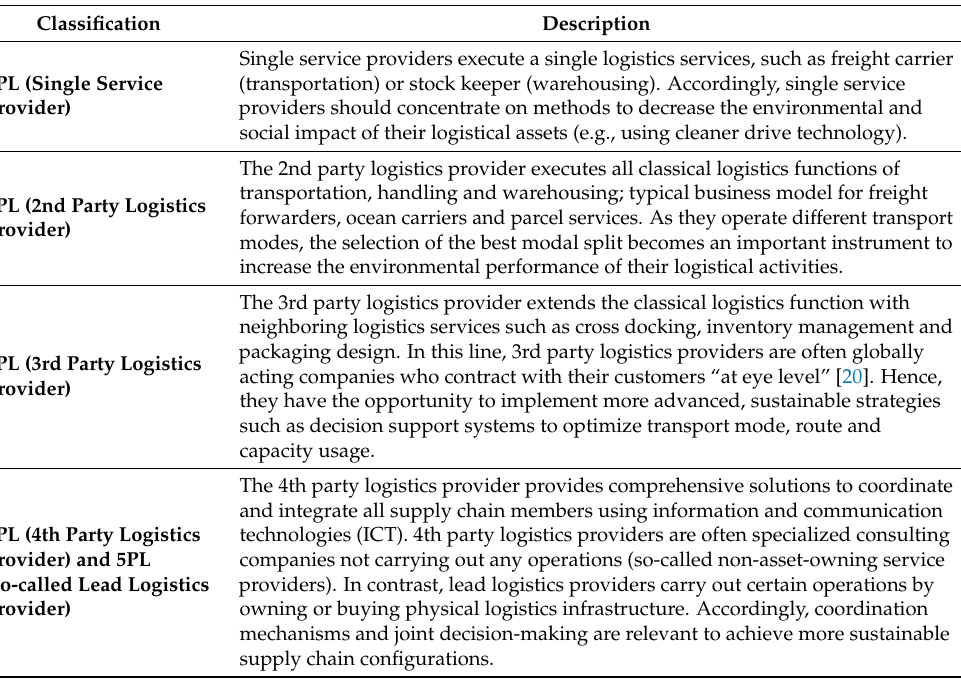
Table 1. 1PL to 5PL scheme and related sustainable logistics practices